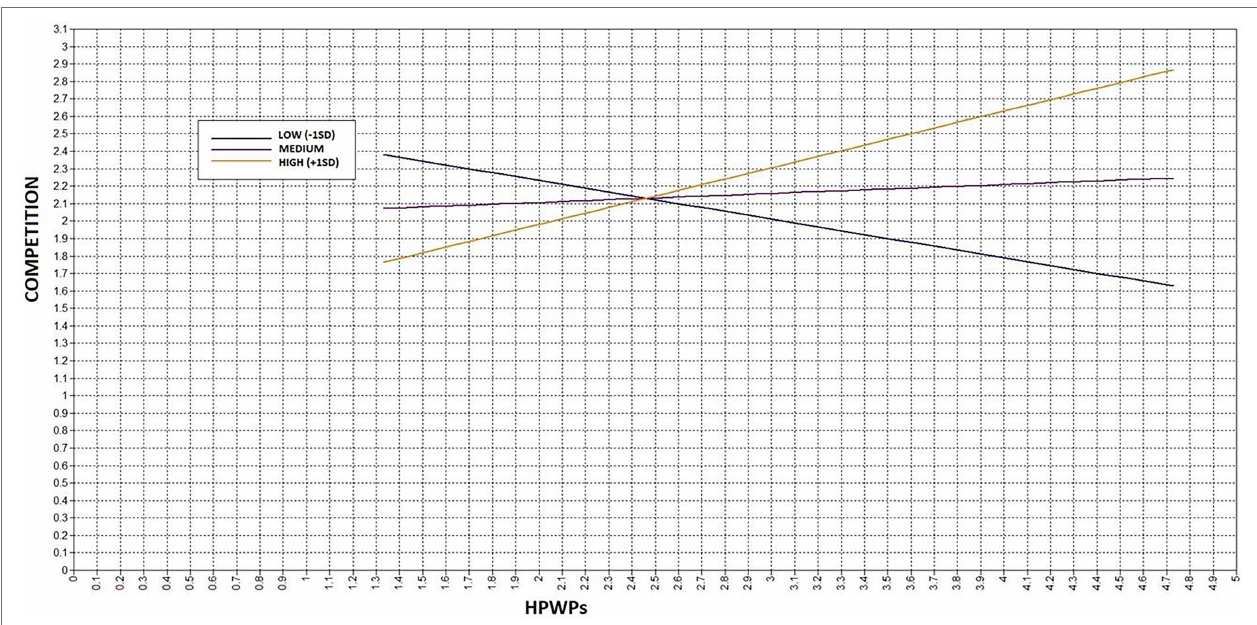
FIGURE 2 | The relationship between HPWPs and competition at three levels of the moderator ( laissez-fair